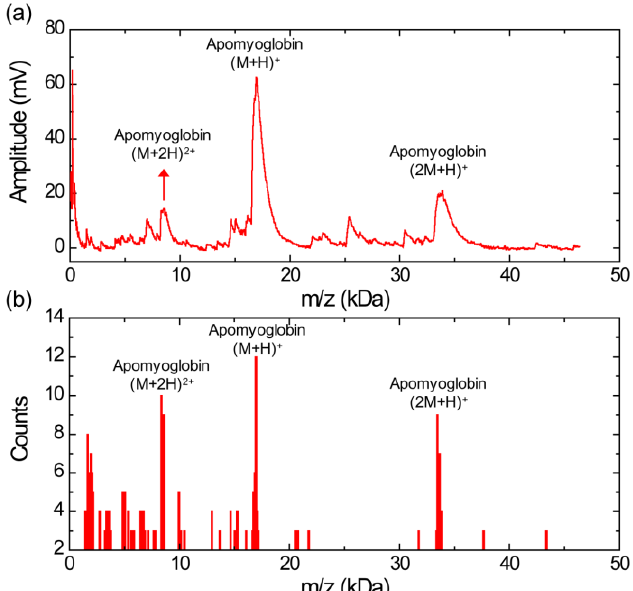
Figure 2. ( a ) MALDI-TOF mass spectrum for apomyoglobin with sinapinic acid matrix obtained using silicon nanomembrane detector, showing singly charged ion, doubly charged ion, and singly charged dimer ion. ( b ) Histogram of the MALDI-TOF mass spectrum, showing a relative abundance of apomyoglobin ions in the sample under